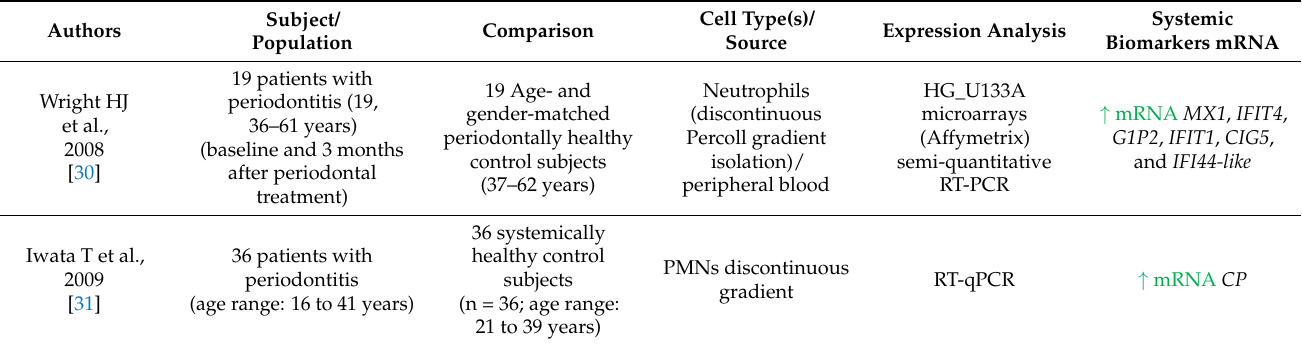
Table 7. Studies on mRNA expression in peripheral blood Polymorphonuclears (PMNs) or subcom- ponents